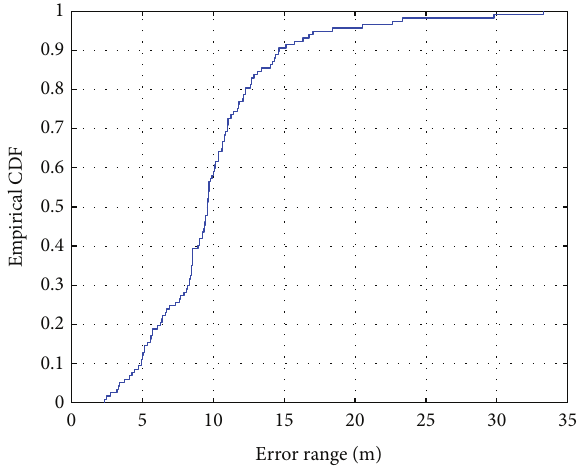
Figure 13: Comparison of total energy consumption of nodes (1min): GPS versus ECOPS.